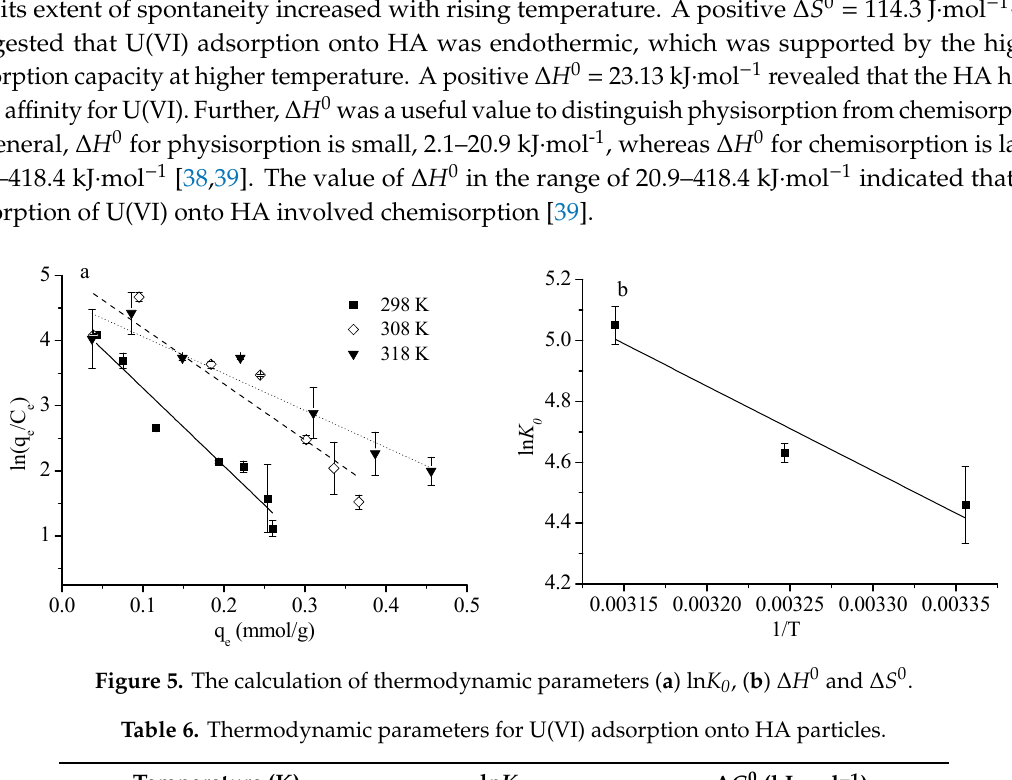
Figure 5. The calculation of thermodynamic parameters ( a ) ln K 0 , ( b ) ∆ H 0 and ∆ S 0 . Table 6. Thermodynamic parameters for U(VI) adsorption onto HA particles. Temperature (K)